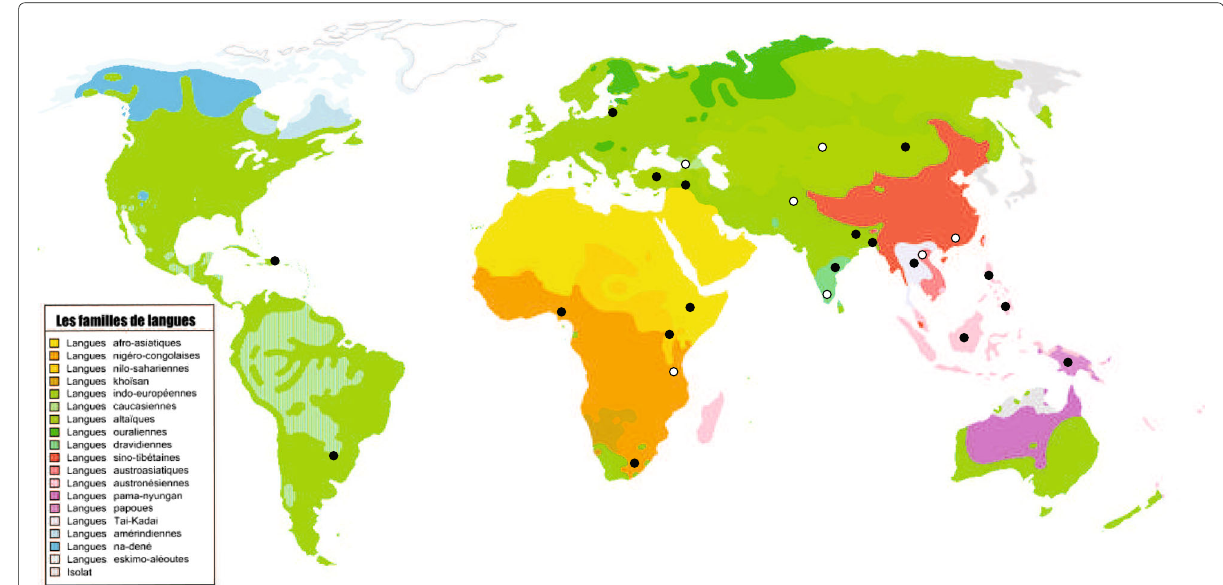
Fig. 4 The distribution of Babel languages. The white points represent the selected